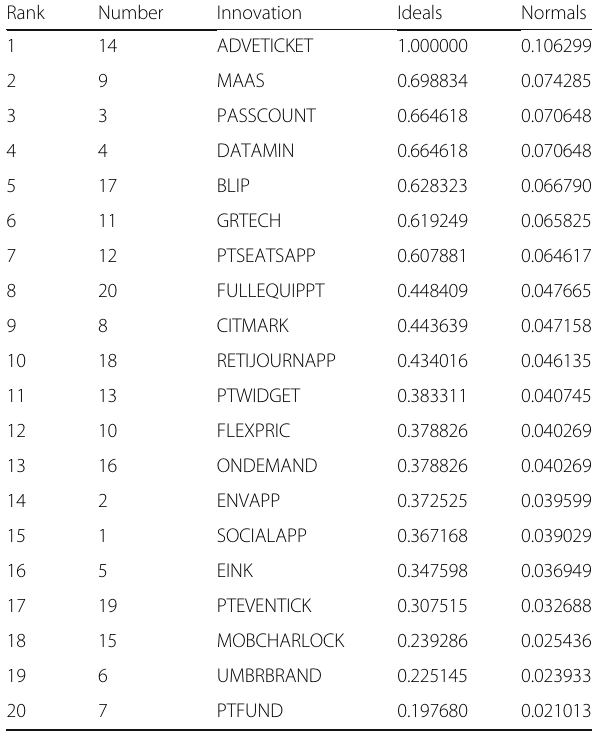
Table 7 Ranking of innovations with respect to Innovativeness Rank